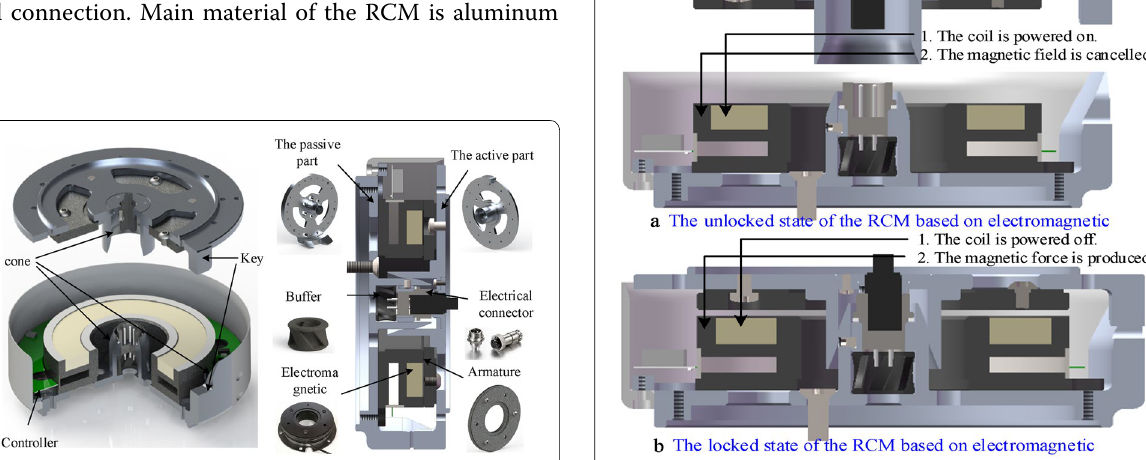
Figure 12 Structure of RCM based on electromagnetic Figure 13 State of the RCM based on